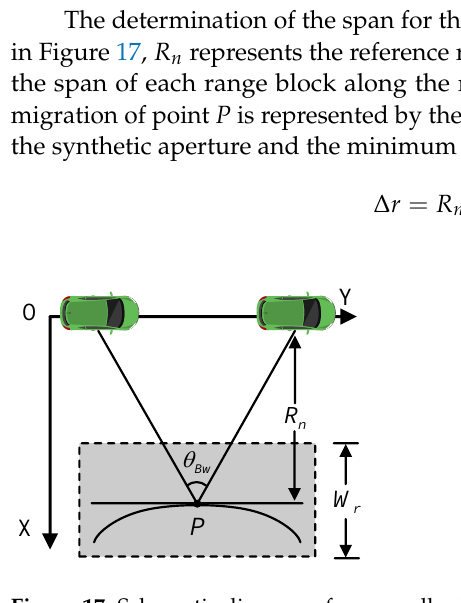
Figure 17. Schematic diagram of range cell migration.